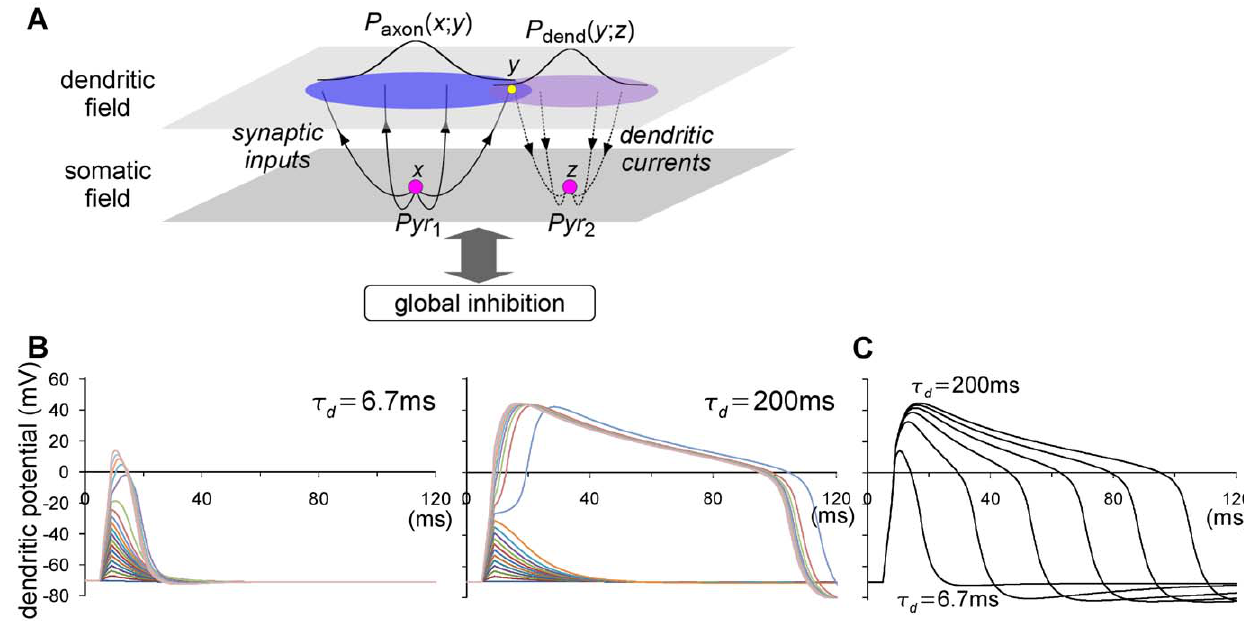
Figure 1. Two-field model. (A) A schematic introduction to the two-field model. The somatic (lower) and dendritic (upper) fields consist of two- dimensional arrays of somatic and dendritic units, respectively. The numbers of units in somatic and dendritic fields are 14,400( ~ 120 2 ) and 90,000( ~ 300 2 ) , respectively. A somatic unit of the pyramidal neuron Pyr 1 that is located at x (left magenta dot), extends the axonal arbors to a dendritic unit that is located at y (yellow dot) according to probability P axon ( x ; y ) . A somatic unit of the pyramidal neuron Pyr 2 that is located at z (right magenta dot), extends the dendritic branches to a dendritic unit that is located at y according to probability P dend ( y ; z ) . There are no direct connections between the units within each field. Global feedback inhibitory inputs are assumed. (B) Trajectories of the dendritic membrane potential with small t d ( 6 : 7 ms ; left) and large t d ( 200 ms ; right). Current pulses, of which the intensity ranges between 1 and 20 pA, were injected for 4 ms. Abrupt jumps in the amplitudes were observed. (C) The trajectory of the dendritic membrane potential changes depending on the dendritic time constant, t d , of which the values are 6 : 7,40,80,120,160 and 200 ms (lower to upper). The intensity and the duration of stimulation current pulses were 20 pA and 4 ms,